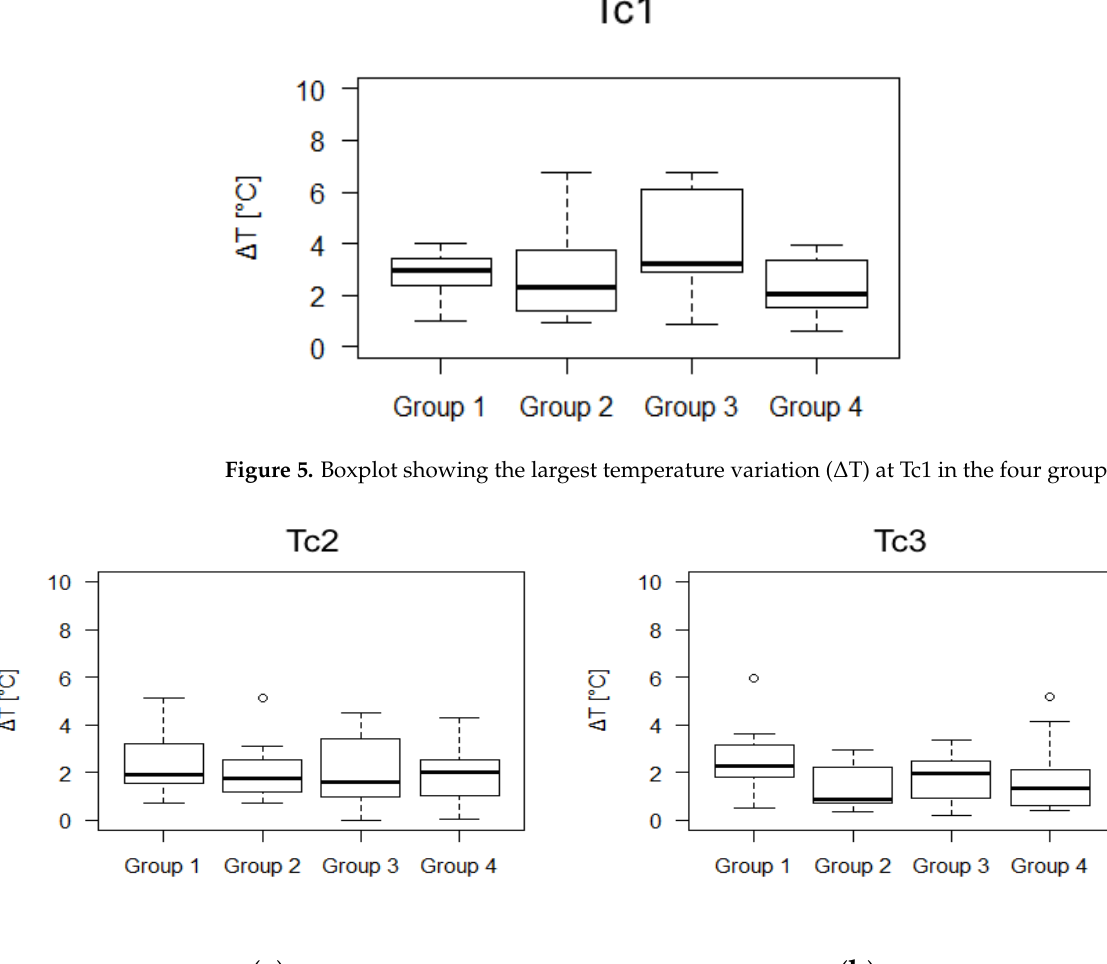
Figure 6. Boxplots showing the largest of temperature variation ( ∆ T) at Tc2 ( a ) and Tc3 ( b ) in the four groups. Figure 6 . Boxplots showing the largest of temperature variation (ΔT) at Tc2 ( a ) and Tc3 ( b ) in the four groups. The largest temperature variation at Tc3 showed a median of 2.3 ◦ C (IQR 1.8–3.5 ◦ C) in Group 1, which was not statistically different than Group 2 (median 0.9 ◦ C, IQR 0.7–2.2 ◦ C; p adj = 0.15), Group 3 (median 2.0 ◦ C, IQR 0.9–2.5 ◦ C; p adj = 0.15) or Group 4 (median 1.3 ◦ C, IQR 0.6–2.1 ◦ C; p adj = 0.27) (Figure 6 and Table S1). Among the secondary outcome measures, the average temperature increment with respect to starting temperature is displayed in Figure 7 and Table S2. At Tc1, the average temperature increment showed a median of 1.0 ◦ C (IQR 0.7–1.6 ◦ C) in Group 1, which was not statistically different than Group 2 (median 0.8 ◦ C, IQR 0.5–1.1 ◦ C; p adj = 0.42), Group 3 (median 1.3 ◦ C, IQR 0.8–2.3 ◦ C; p adj = 0.51) or Group 4 (median 0.8 ◦ C, IQR 0.4–1.0 ◦ C; p adj = 0.48).